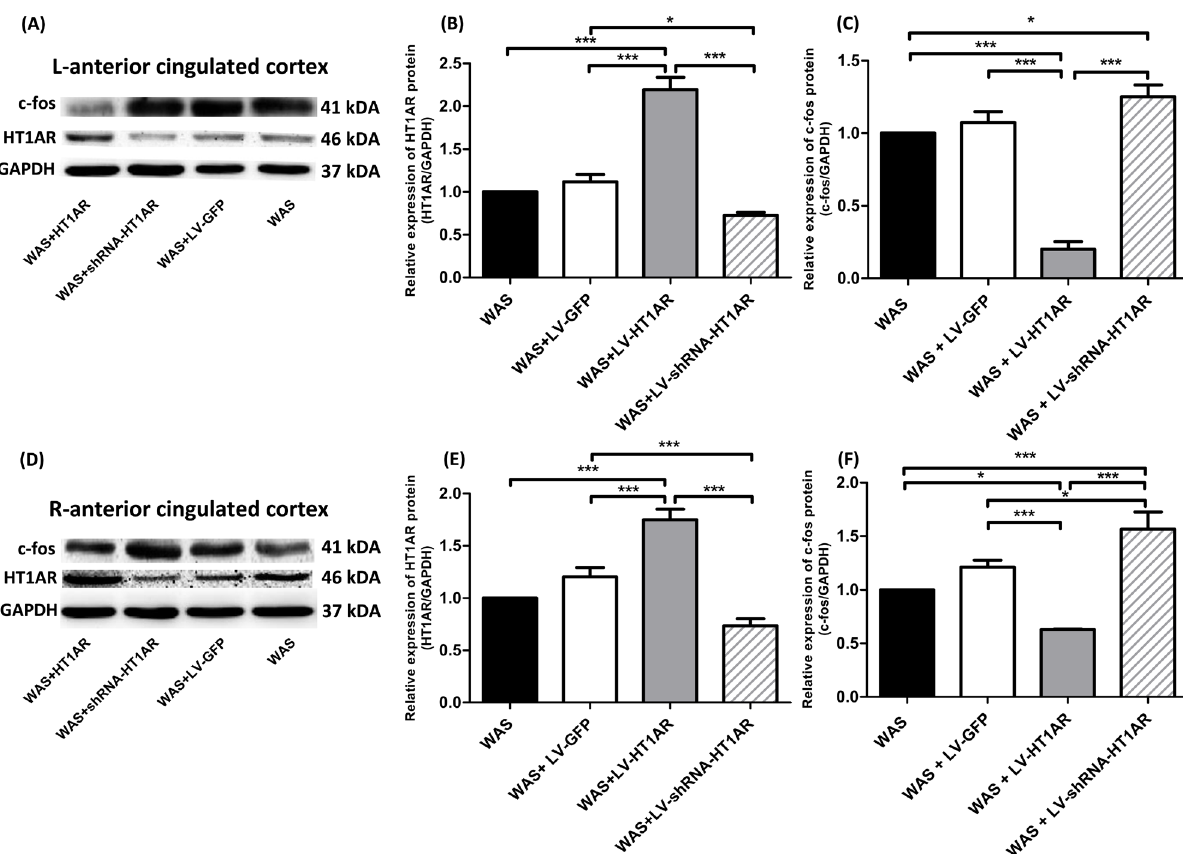
Figure 3: Effects of lentivirus intervention on expression of HTR1A and c-fos in the ACC. (A) Representative immunoblots from the left ACC. (B)(C) Protein expression levels of HTR1A and c-fos in the left ACC were compared among WAS, WAS+LV-GFP, WAS+LV-HTR1A and WAS+LV- shRNA-HTR1A groups. (D) Representative immunoblots from the right ACC. (E)(F) Protein expression levels of HTR1A and c-fos in the right ACC were compared among WAS, WAS+LV-GFP, WAS+LV-HTR1A and WAS+LV-shRNA-HTR1A groups. * P<0.05, ** P<0.01, *** P<0.001.